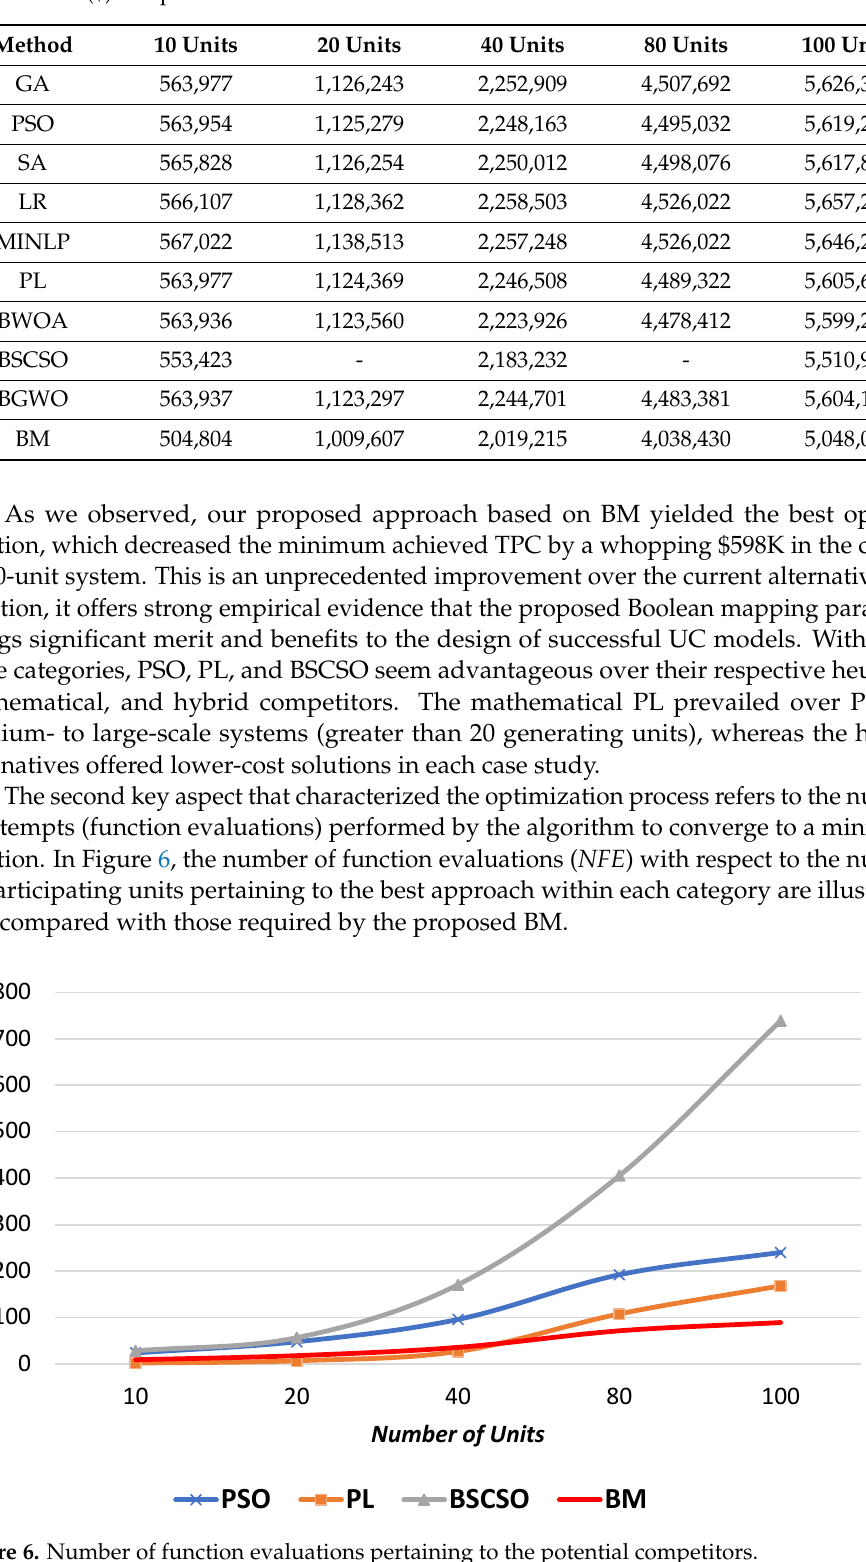
Table 7. Cost ($) comparisons under different case studies.